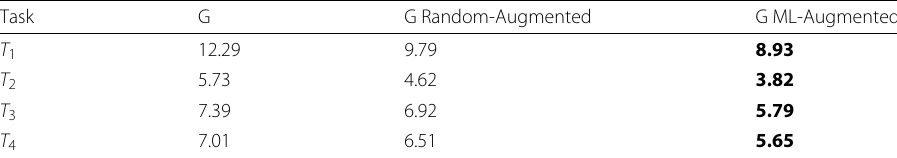
Table 2 Average Cardinality of Teams for Task of size 10 — Samsung Graph Task